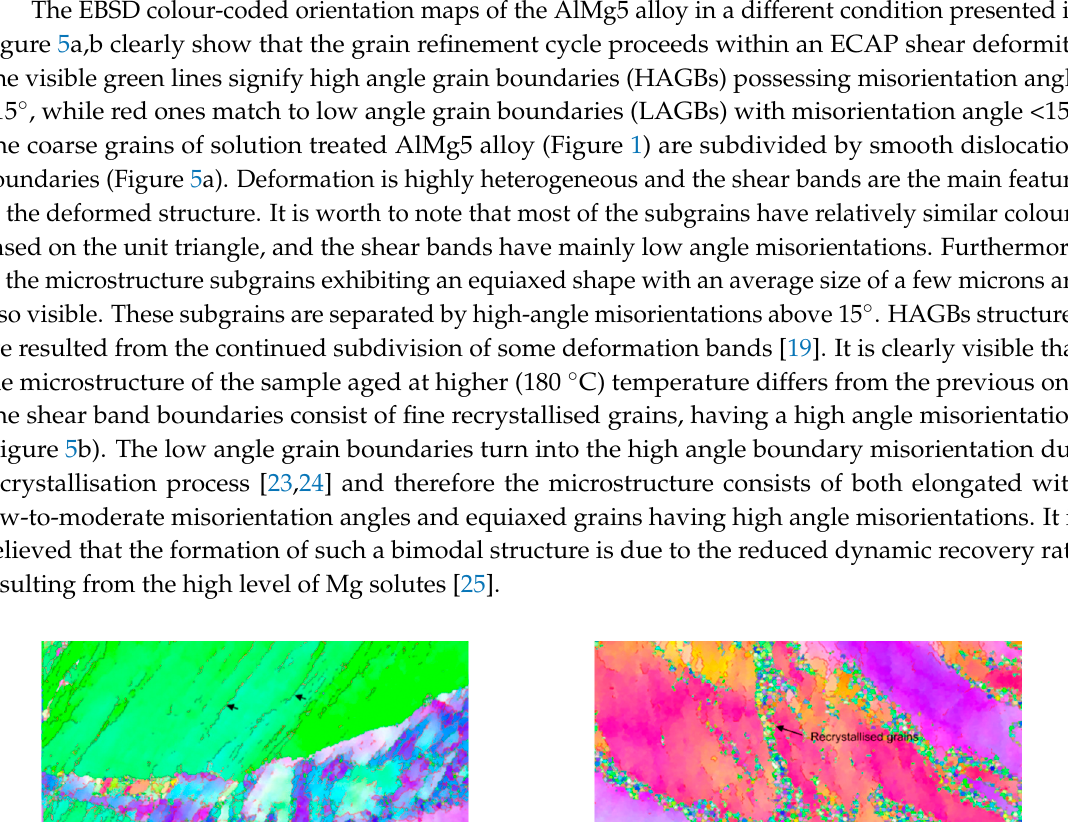
Figure 4. Microstructures of the AlMg5 samples ( a ) ST + ECAP 2× +ageing 160 °C for 4 h, ( b ) ST + ECAP 2× + ageing 180 °C for 4 h.